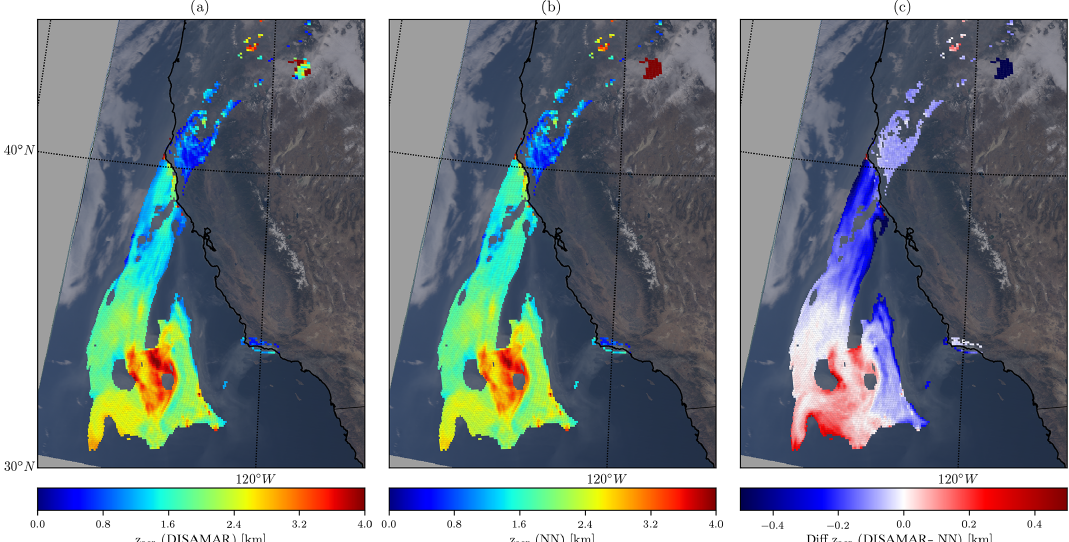
Figure 9. (a) Aerosol layer height retrieved using DISAMAR as the forward model. (b) The same, but with NN replacing DISAMAR in the operational processor. (c) Difference between DISAMAR and NN retrieved aerosol layer